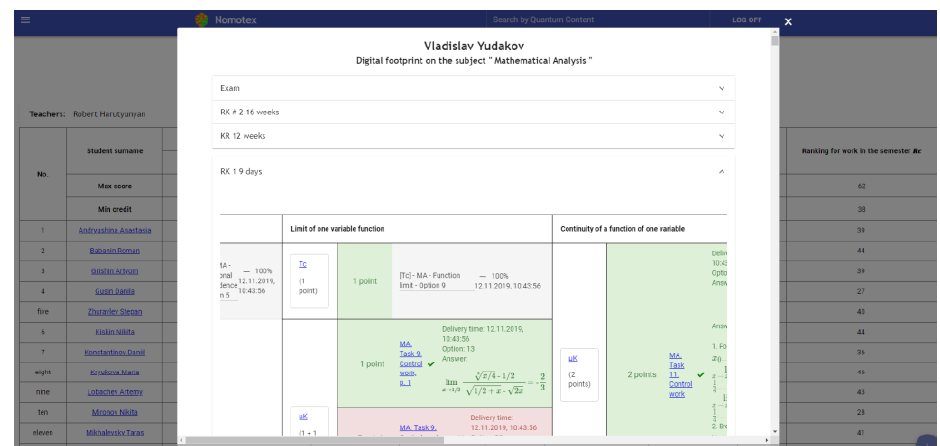
Fig. 8. Ticket to the control event on Mathematical Analysis in the student's personal account in the DLS "Nomotex" Points for a ticket are summed up automatically and are taken into account in the student's overall rating for the semester.